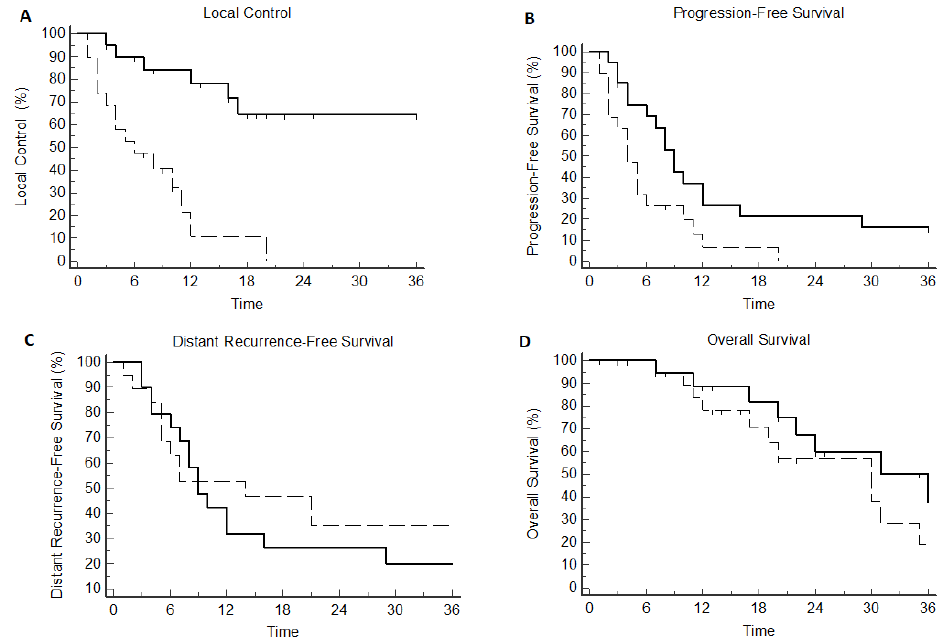
Figure 3. Kaplan–Meier plot according to treatment arm for local control ( A ), Progression-Free Survival ( B ) Distant Recurrence Free Survival ( C ) and Overall Survival ( D ). Solid line: Stereotactic Body Radiotherapy. Dashed line: Transarterial Embolization/Transarterial